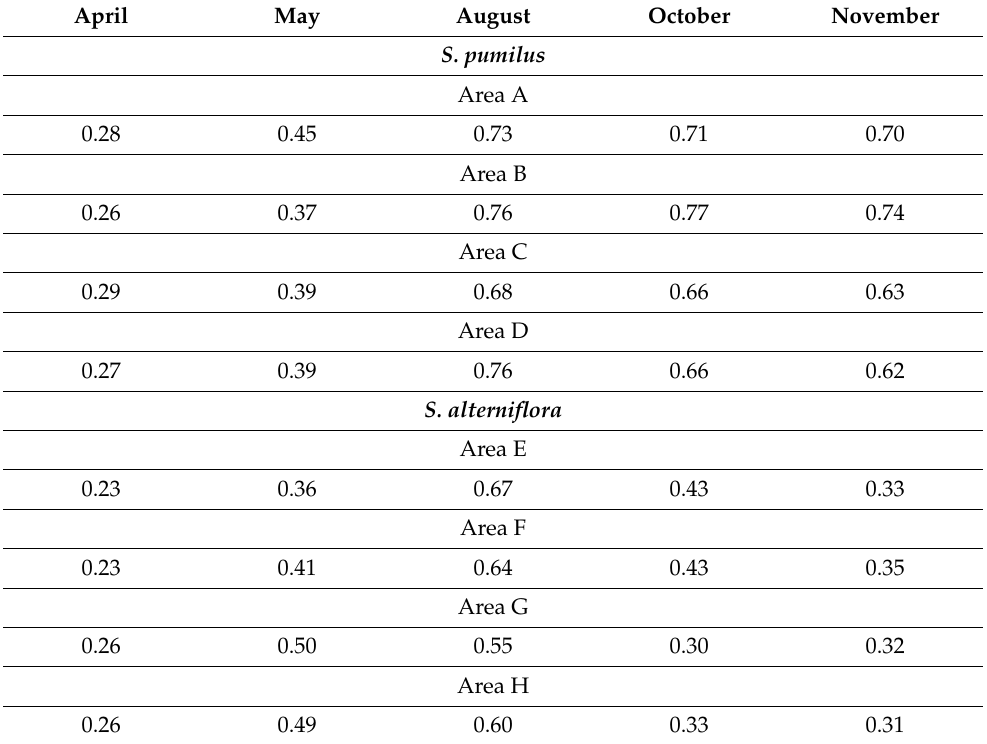
Table 2. Monthly NDVI values in the high marsh ( S. pumilus ) and low marsh ( S. alterniflora ) zones.